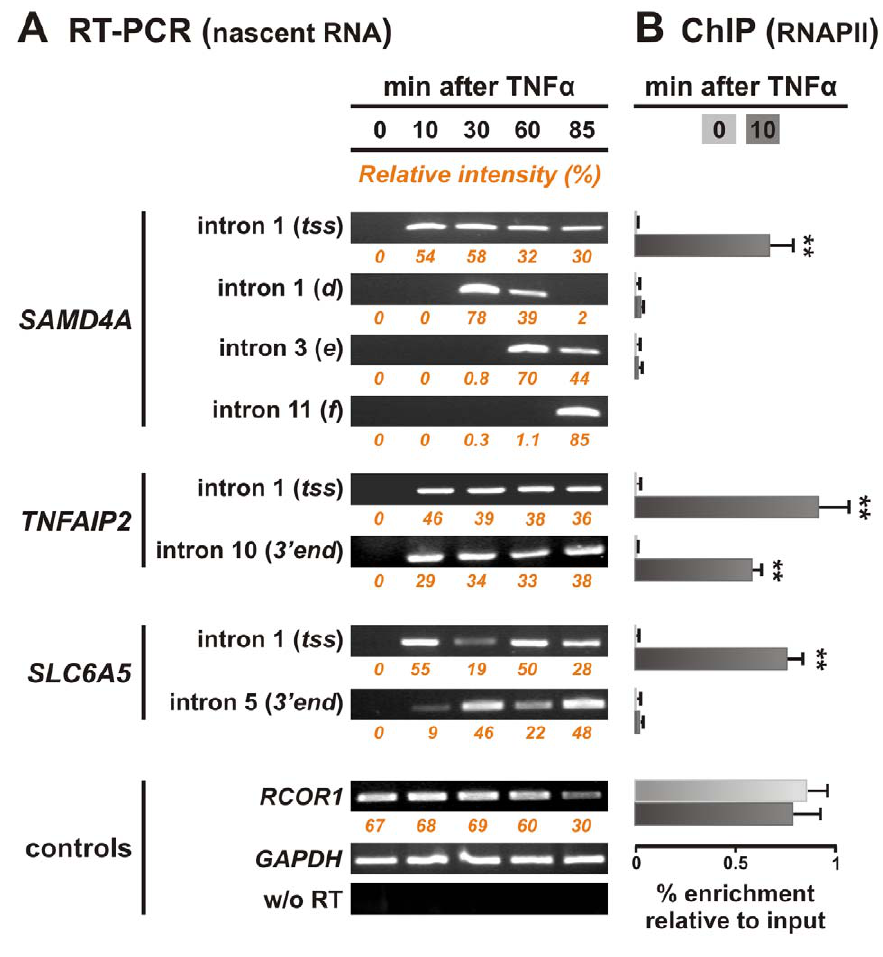
Figure 2. Polymerases initiate rapidly and synchronously on responding genes and elongate at expected rates. (A) Nascent RNA detected using reverse transcriptase PCR (RT-PCR). Total RNA was isolated from HUVECs 0–85 min after adding TNF a , treated with DNase, and intronic RNAdetected. Nonascent RNA copiedfrom SAMD4A , TNFAIP2 , or SLC6A5 is detected at 0 min. For221 kbp SAMD4A , nascent RNAappears at the tss after 10 min. As polymerases continue to initiate thereafter (albeit at declining rates), signal is seen at the tss between 15 and 85 min; however, many of these polymerases abort within , 10 kbp of the tss (Figure S1; [9]). Nascent RNA from region d of intron 1 (34 kbp into the gene) is seen only after 30 min. Pioneering polymerases reach this region after 30 min and the slowest by 60 min; after 85 min all have passed by. Similarly, pioneering polymerases only reach introns 3 and11 after60 and85 min, respectively. TNFAIP2 is 11 kbp, andpolymerases in the population cangenerate intronic RNAfrom both 5 9 and 3 9 ends within 10 min (it is then transcribed throughout the 85 min). SLC6A5 —a 56 kbp gene—yields an intermediate pattern. No signal is again seen at 0 min, and pioneering polymerases generate maximal levels of intronic RNA at the tss after 10 min, and the 3 9 end after 30 min; then, the cycle repeats between 60 and 85 min. Controls show levels of intronic RNA from two non-responsive, active genes ( GAPDH and RCOR1 ), and that amplimers do not result from contaminating genomic DNA (using GAPDH probes, but replacing RT by Taq polymerase). Numbers under each panel (orange) correspond to the relative intensity of bands, corrected for background, and normalized to GAPDH levels. (B) Bound RNA polymerase II detected by chromatin immunoprecipitation (ChIP). Enrichments relative to input DNA (normalised to GAPDH levels) are shown 0 and 10 min after stimulation (light and dark grey bars, respectively). Almost no polymerase is bound to any part of SAMD4A , TNFAIP2 , or SLC6A5 at 0 min. The tss of SAMD4A is occupied by polymerases within 10 min of induction; however, levels further 3 9 remain low as pioneering polymerases have not yet reached these regions. For TNFAIP2 , some polymerases bind after 10 min, while others have reached the 3 9 end as the gene is so short. For SLC6A5 , polymerases bind by 10 min to the tss but have not yet reached the 3 9 end. RCOR1 was analyzed as it was used as a control in RNA FISH experiments. Error bars show standard deviations from two independent experiments. ** p , 0.01, Student’s t test compared to 0